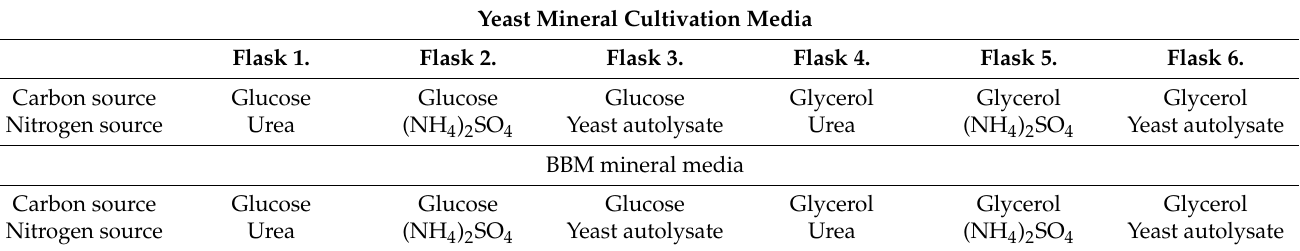
Table 1. Experimental scheme of first co-cultivation